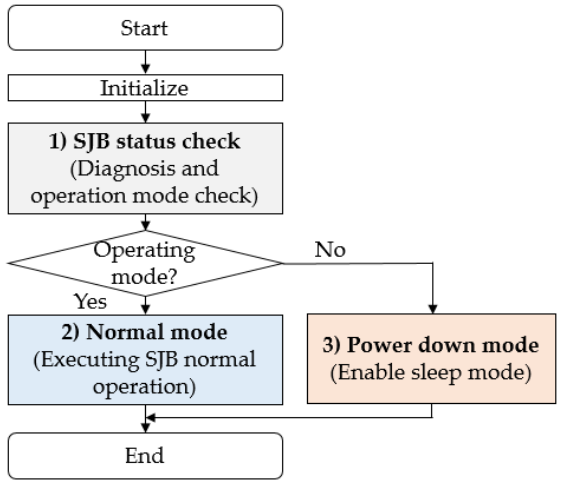
Figure 8. Flow chart of the software.